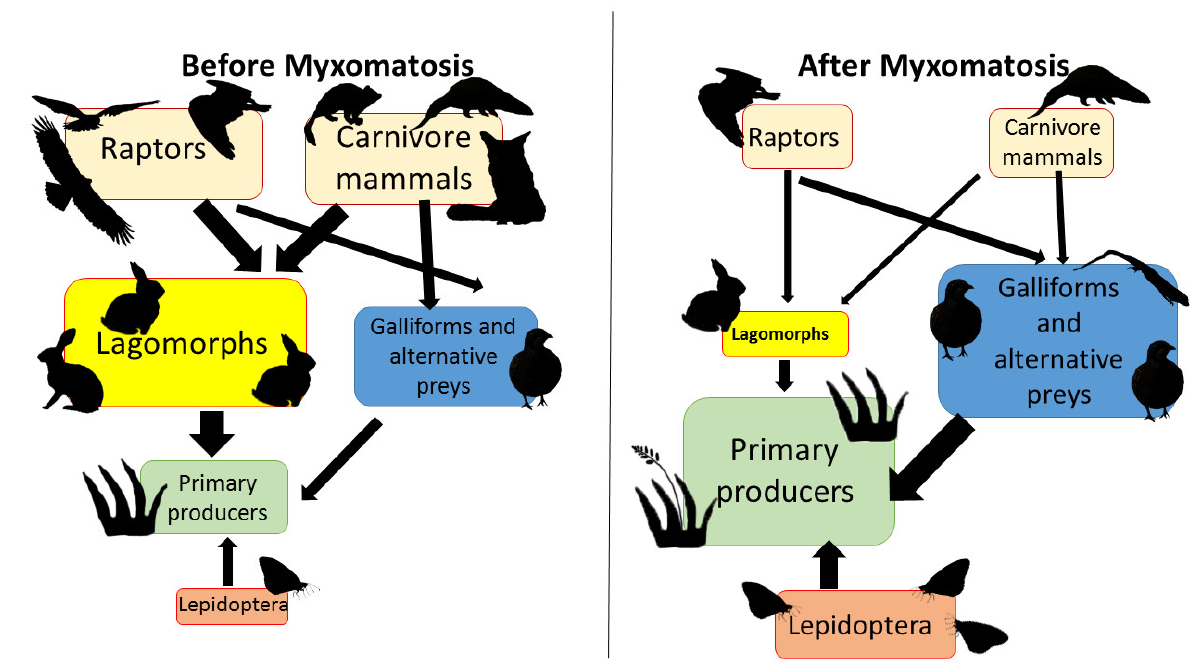
Figure 7. Scheme of the impact of lagomorph depletion in the trophic chain of a pseudo-steppe agricultural land. The direction of arrows indicate which group predates or consumes over the other.